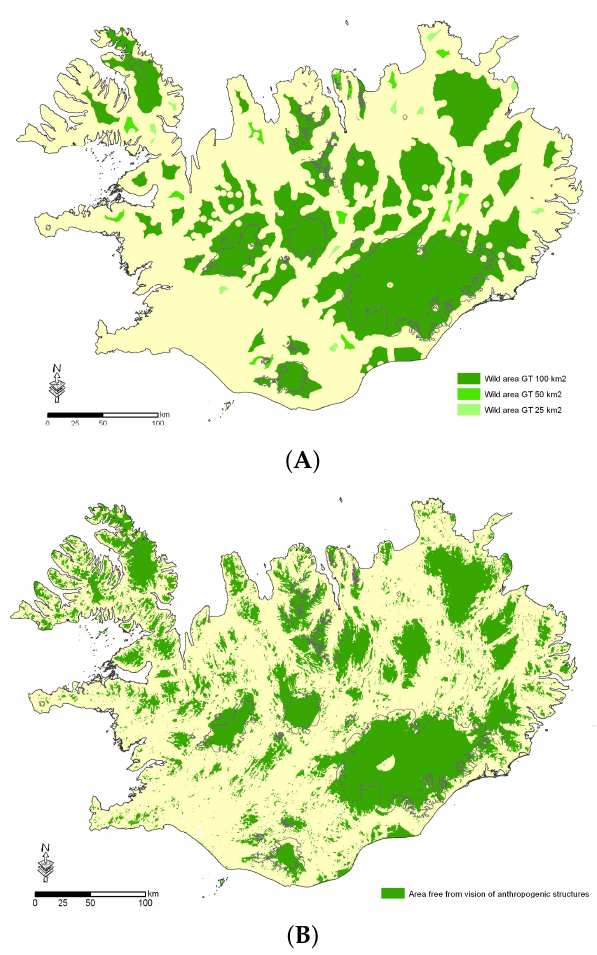
Figure 1. Wilderness mapping from Ó lafsd ó ttir and Runnström based on the definition of Icelandic wilderness according to Act no. 44 / 1999 on nature conservation. ( A ) shows calculation based on a distance analysis and ( B ) calculation based on a viewshed analysis